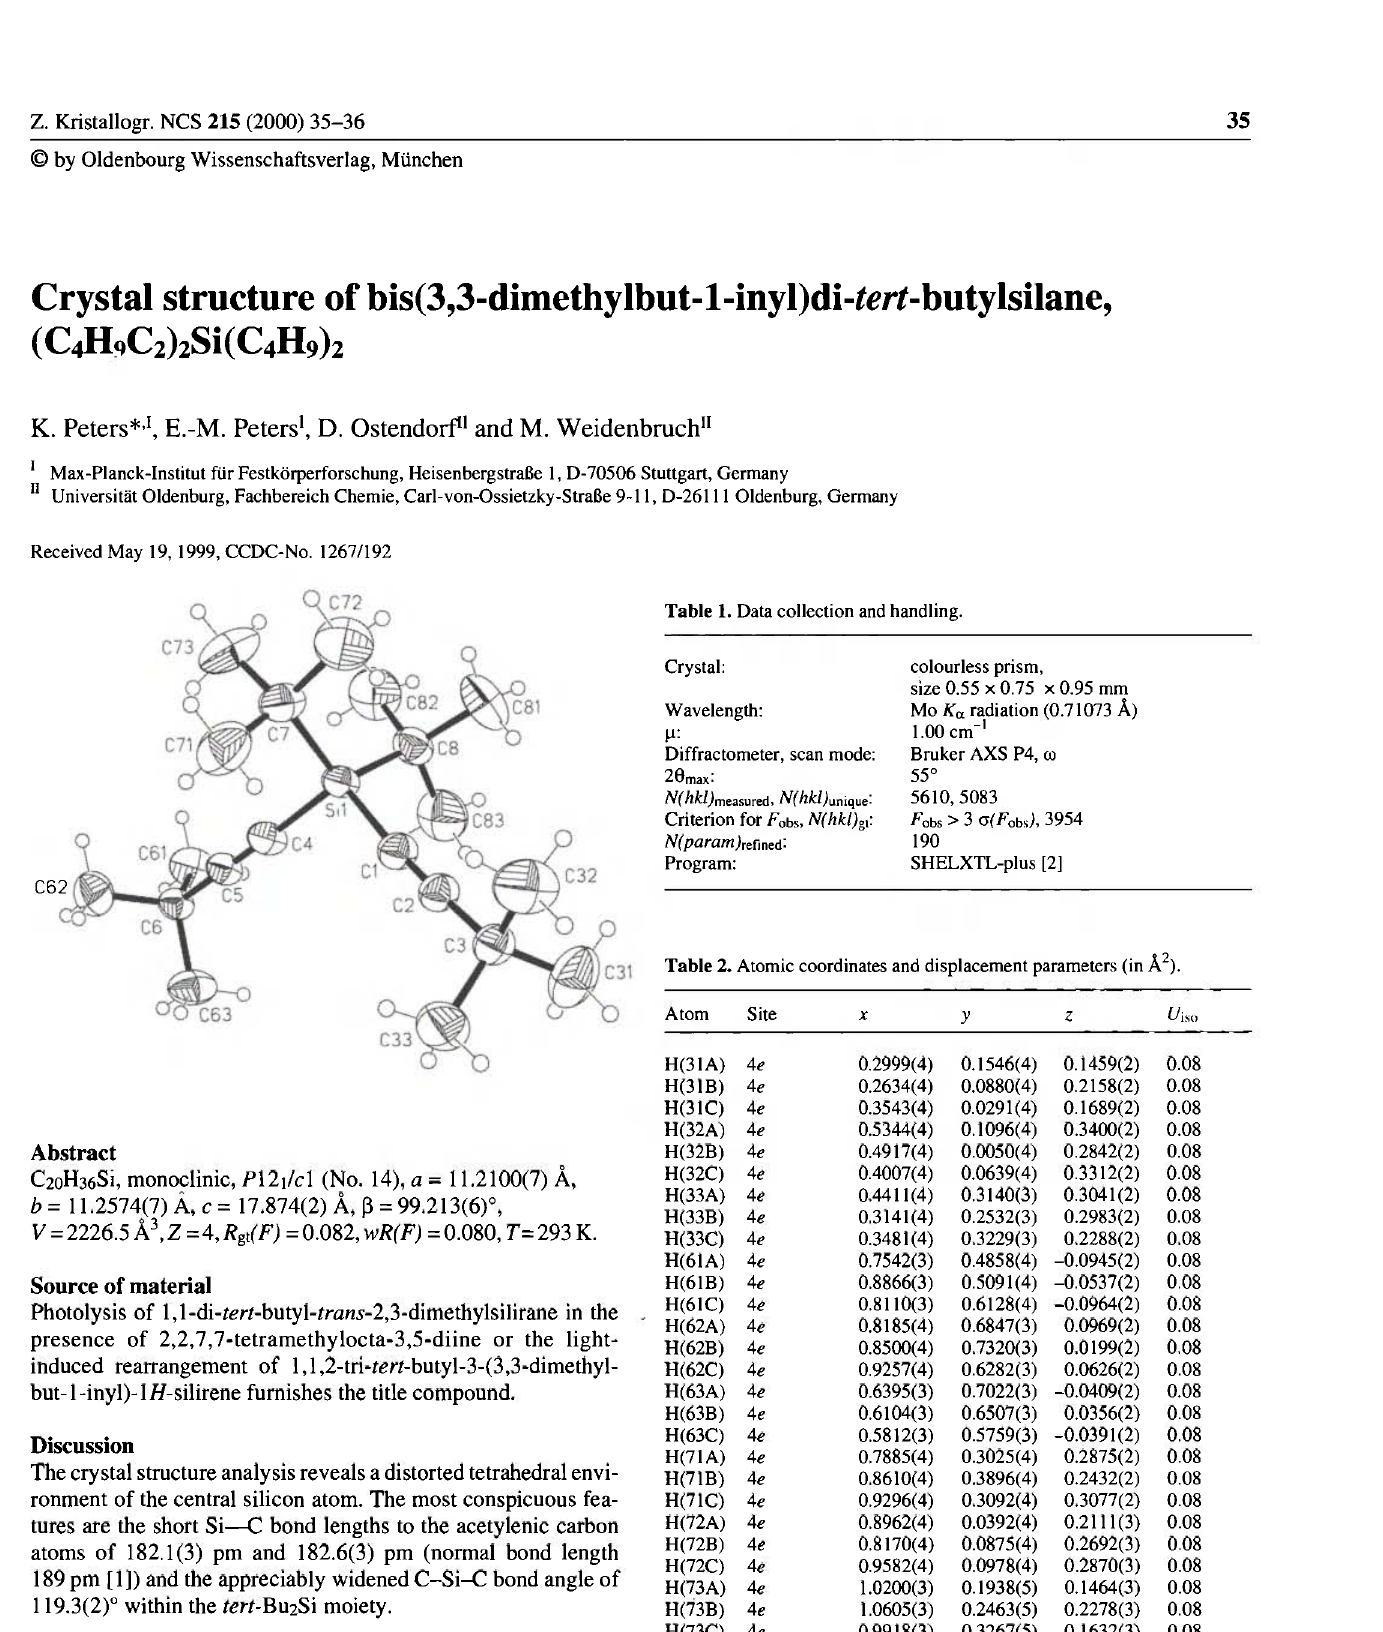
Table 2. Atomic coordinates and displacement parameters (in Ä 2